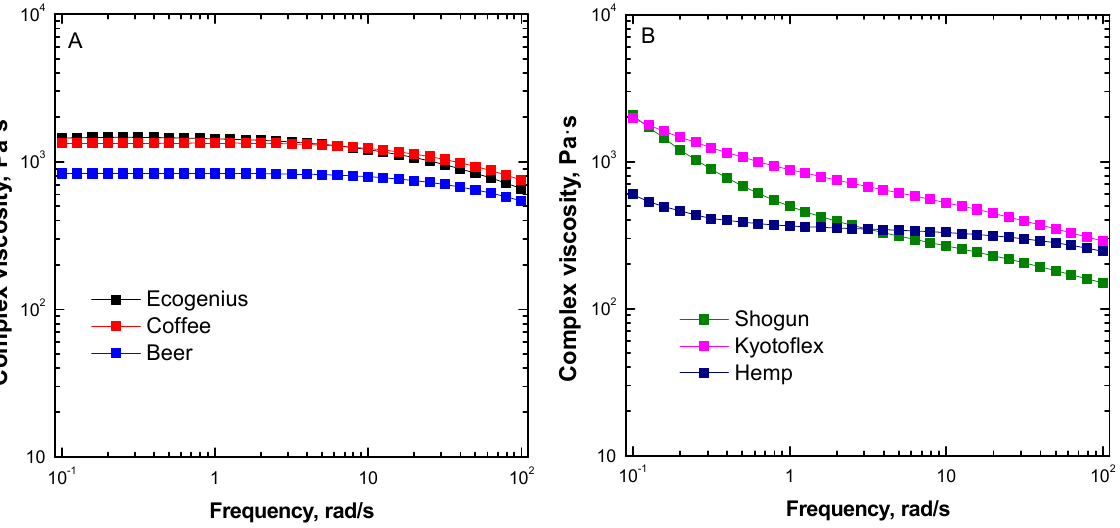
Figure 2. Complex viscosity curves for PLA-based materials showing ( A ) Newtonian plateau, and ( B ) yield stress.